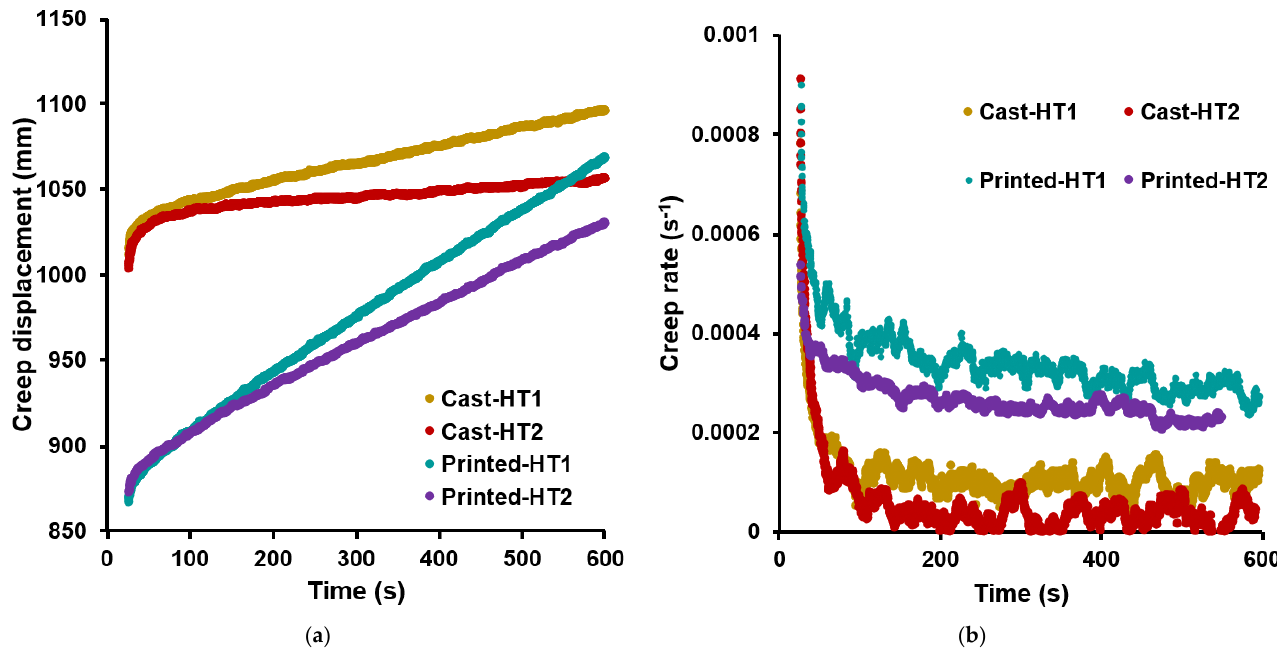
Figure 8. ( a ) Creep displacement vs. constant load holding time; ( b ) creep strain rate vs. constant load holding time for two heat ‐ treated samples in cast conditions and two heat ‐ treated samples in a printed condition.